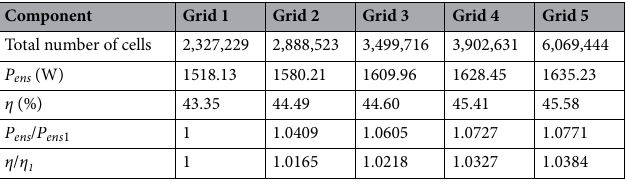
Table 2. Grid independence